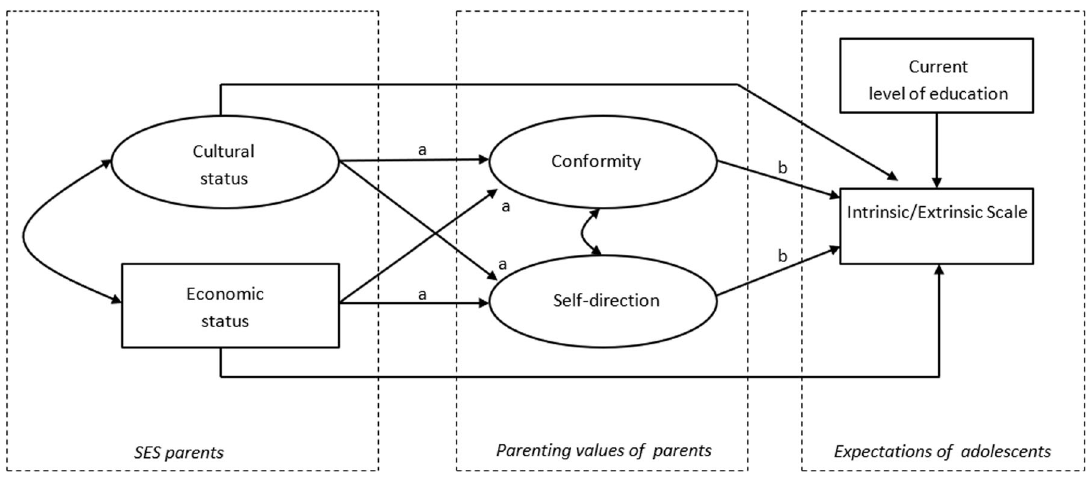
Fig. 1 The estimated structural equation model; dependent variable is the intrinsic/extrinsic rewarding fi elds of study scale. Note: ( a ) The direct effects of SES on parenting values, ( b ) direct effects of parenting values on adolescent expectations. The direct effects of SES on adolescent expectations are non-mediated